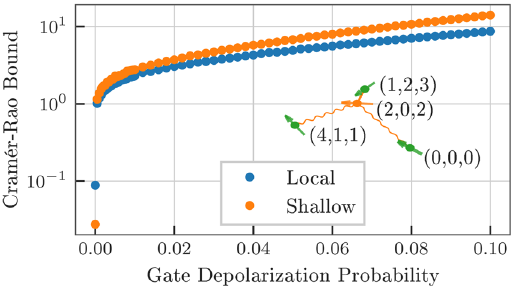
Fig. 4 NV trilateration results. Semi-logarithmic plot of the weighted Cramér-Rao bound for NV trilateration over the gate depolarization probability of (blue) local probes and (orange) shallow entangled probes. Each dot marks the bound for a probe optimized for the particular gate depolarization probability. The measurement is always local. The inset shows the positions of the NV centers and the target spin used in the experiment. The entangling operations only yield an advantage for vanishing gate